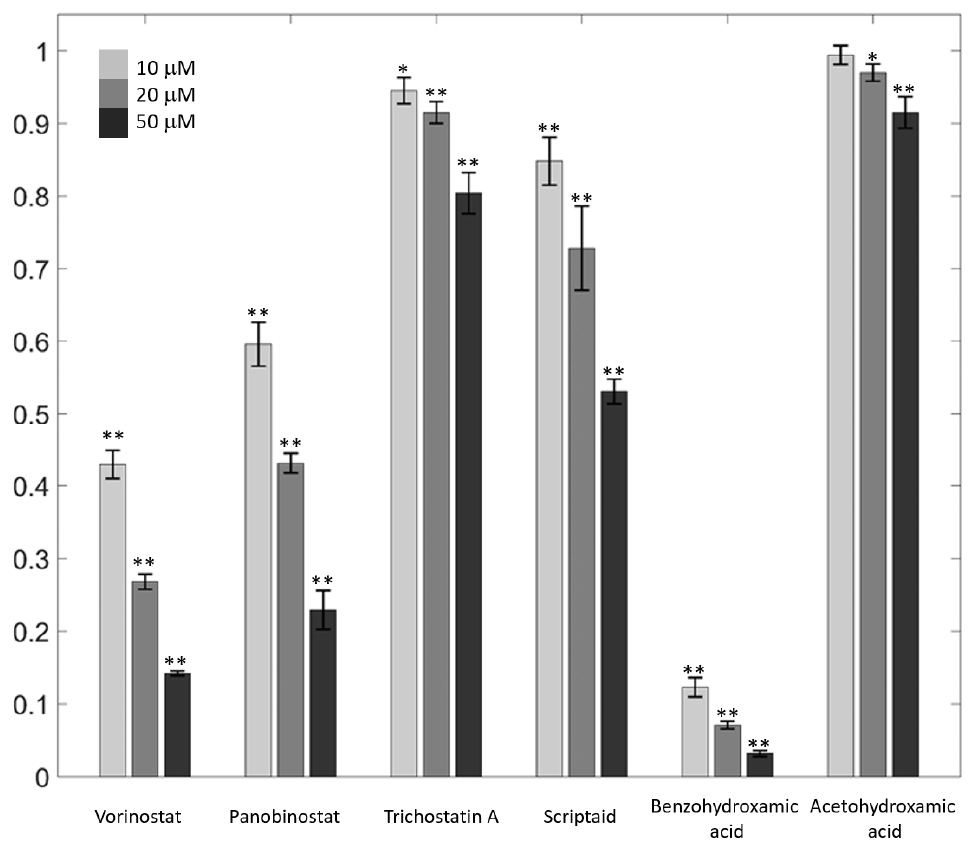
Figure 5. Mammalian-tyrosinase inhibition. B16F10 cell lysates were used to evaluate inhibition against different concentrations of hydroxamate-containing tyrosinase inhibitors. Data are expressed as values relative to those of untreated control cells. Light gray, gray, and dark gray indicate data for inhibitor concentrations of 10, 20, and 50 µ M, respectively. Error bars indicate standard deviations for three repeated independent experiments. * and ** indicate statistically significant differences at the levels of p < 0.05 and p < 0.01, respectively, compared with the controls using t -tests. Nevertheless, we cannot exclude the possibility that the docked poses are inaccurate. Unlike those in di-Zn and di-Mg cases, the surroundings and oxidation states of di-Cu in tyrosinase vary depending on the catalytic cycle. For instance, the interatom distance between two coppers switches from 2.9 to 4.9 Å in the met, deoxy, and oxy states [52–54]; however, there is no experimental clue as to which state hydroxamate-containing inhibitors bind, making docking simulation challenging. A detailed understanding of inhibition at the atomic level may necessitate experimental structure determination of complexes between tyrosinase and new